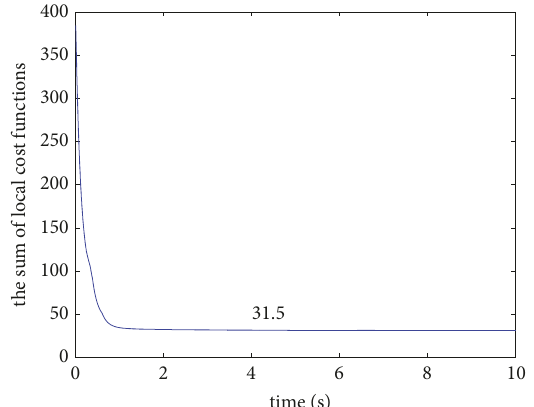
Figure 7: The global cost function under the node-based